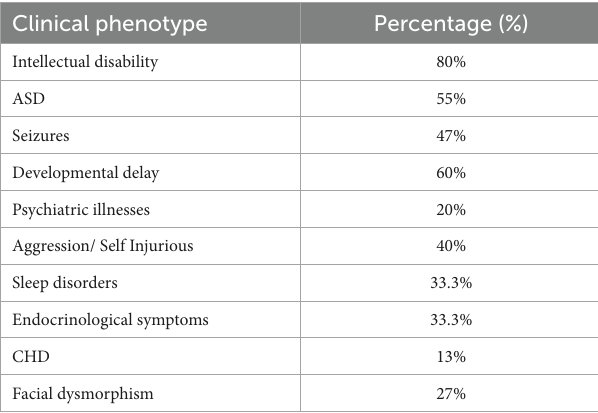
TABLE 3 Reported clinical phenotypes in patients with CACNA1D missense gain of function